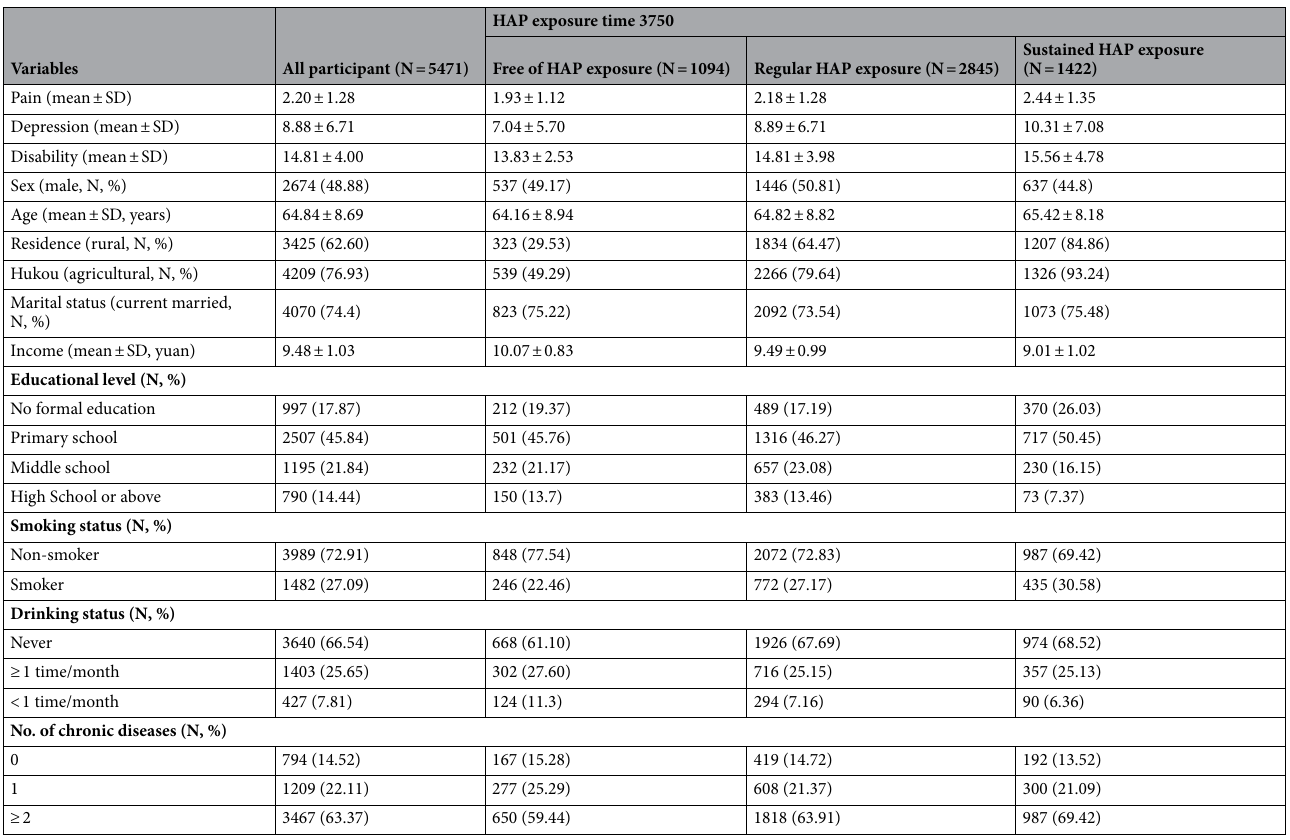
Table 1. The characteristic of the study population (N = 5471). HAP household air pollution, SD standard